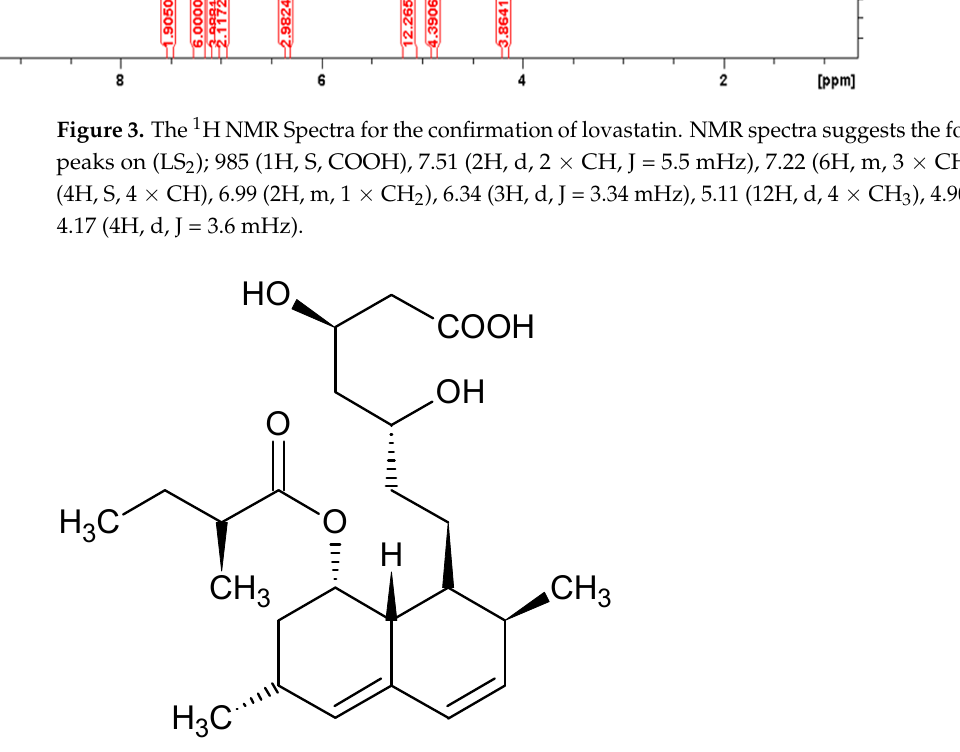
Figure 4. Structure of lovastatin produced by Aspergillus terreus ATE-120 . After the structural confirmation of fermented lovastatin by Nuclear magnetic reso- nance NMR presented in Figure 3, the physical form of the drug was determined by the X-ray diffraction method (XRD) as shown in Figure 5. The diffraction spectra of fermented lovastatin showed sharp and intense peaks of crystallinity. Moreover, the fermented lovas- tatin indicates a decrease in crystallinity or the slightly amorphous nature of the drug. In Figure 5, data given from XRD analysis shows that the fermented drug is 84.2% crystalline. Verma et al. [36] reported that the diffraction spectra of pure LOV showed sharp and intense peaks of crystallinity and X-RD analysis of the pure lovastatin shows that the pure drug is 89.4% crystalline which is in close agreement with our